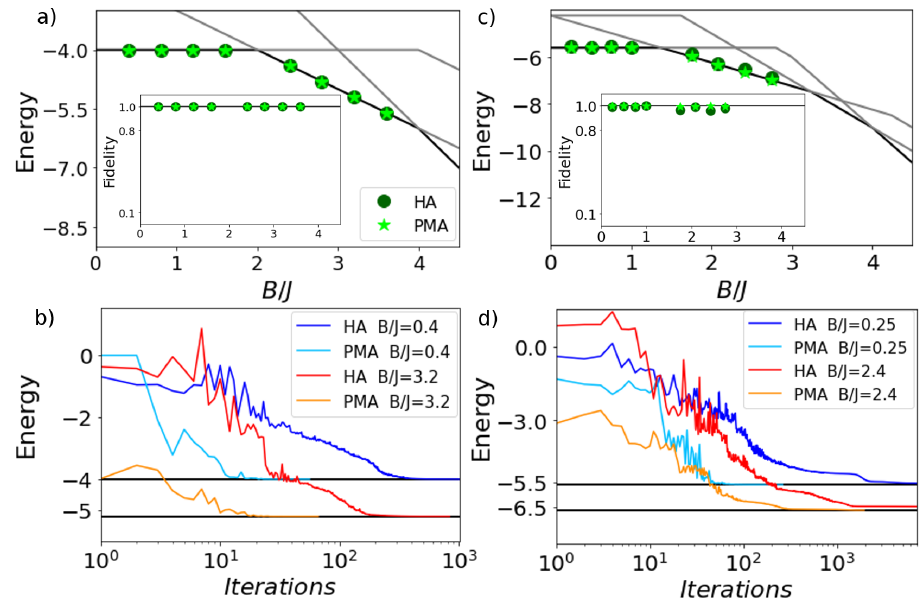
Figure 1. Statevector simulations on four- ( a , b ) and six- ( c , d ) spin rings. ( a ) Ground state energy VQE results using hardware-heuristic (HA, dark-green points) and physically motivated (PMA, light-green stars) ansatzes for different values of B / J . PMA requires only one layer (4 parameters), compared to the 3 or 2 layers needed by HA to converge in the two magnetic-field regions (yielding 16 and 12 parameters, respectively). Each point is the minimal energy solutions of five independents tests with initial parameters randomly set. Inset: corresponding state fidelity. Both ansatz converge to exact solutions (black lines calculated numerically) with high precision. ( b ) Computed energy as a function of VQE iterations for two different values of B / J belonging to the two distinct regions: low B / J = 0.4 (blue-tones) and intermediate B / J = 3.2 (red-tones). COBYLA has been used as classical optimizer. ( c , d ) As for panel a,b) for a six-spin ring. We used 2 layers (4 parameters) with different initial state for PMA and 5 (24 parameters) or 4 (20 parameters) layers for HA to achieve high precision. For HA, ten independent tests were